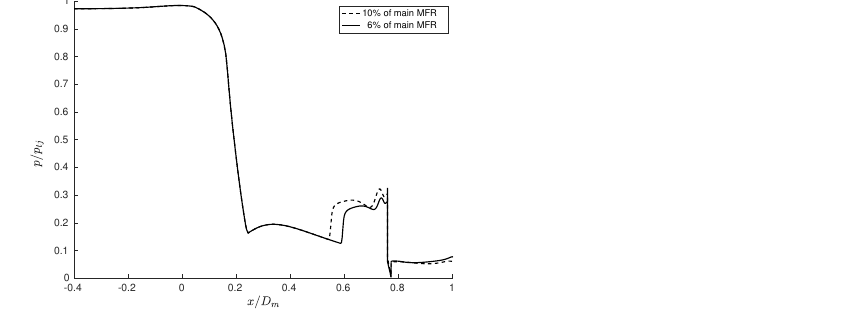
Figure 15. Wall pressure distribution at different secondary mass-flow injections rates ( SMF